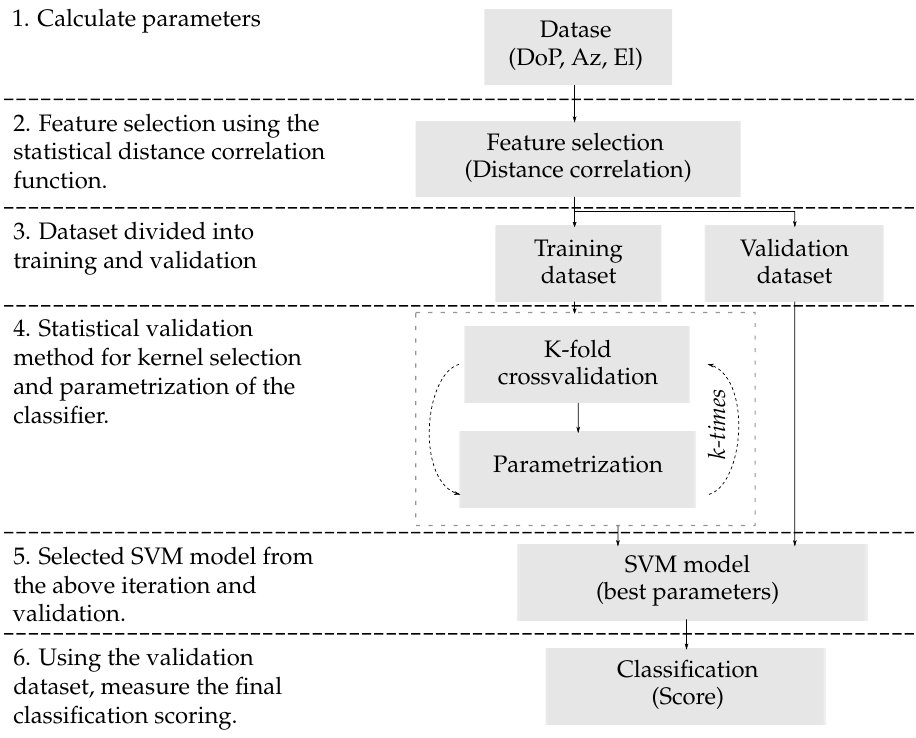
Figure 6. Workflow pipeline for the training, validation and selection of the classification